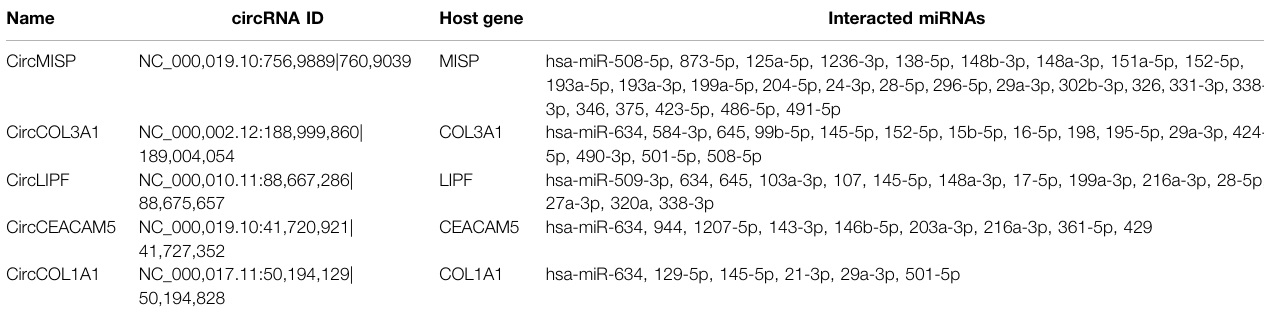
TABLE 4 | The fi ve hub circRNAs, their interacted gastric cancer related miRNAs and the host genes of the circRNAs.